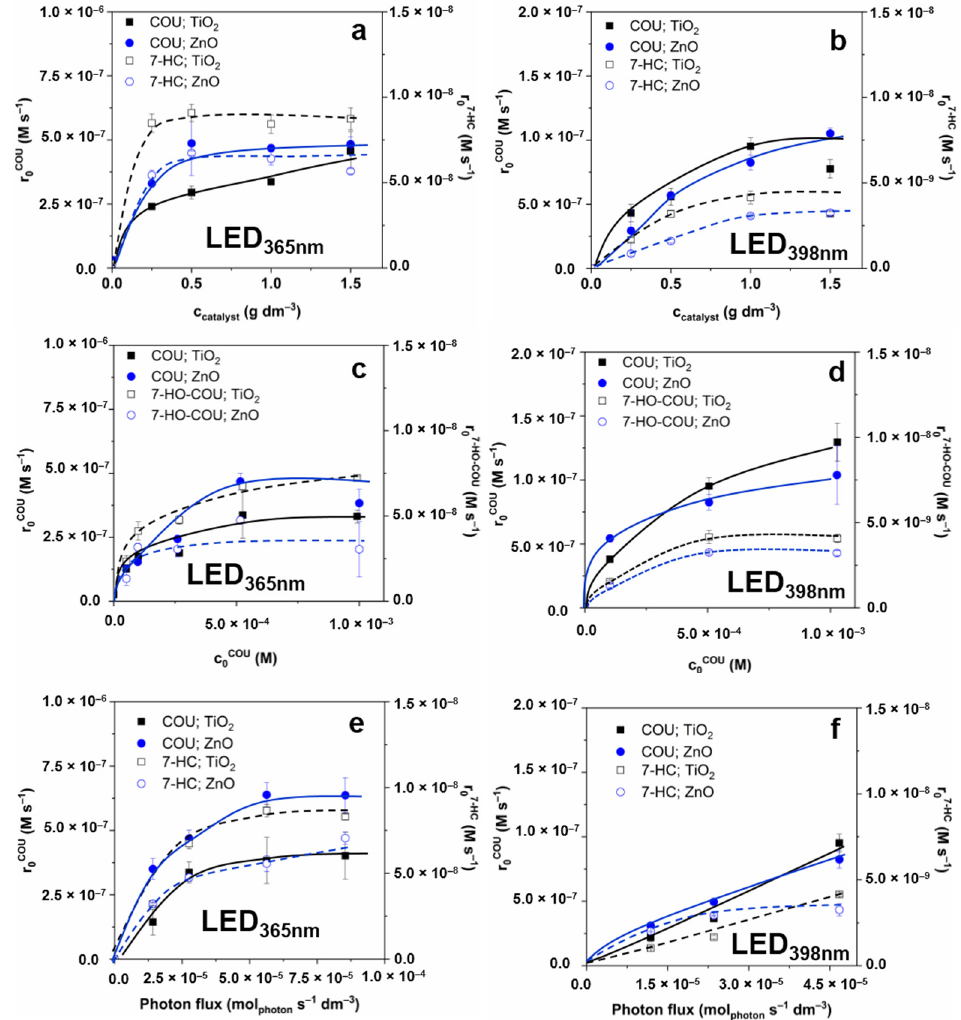
Figure 1. The effect of catalyst load ( a , b ), COU initial concentration ( c , d ), and photon flux ( e , f ) on the initial transformation rate of COU and 7-HC.